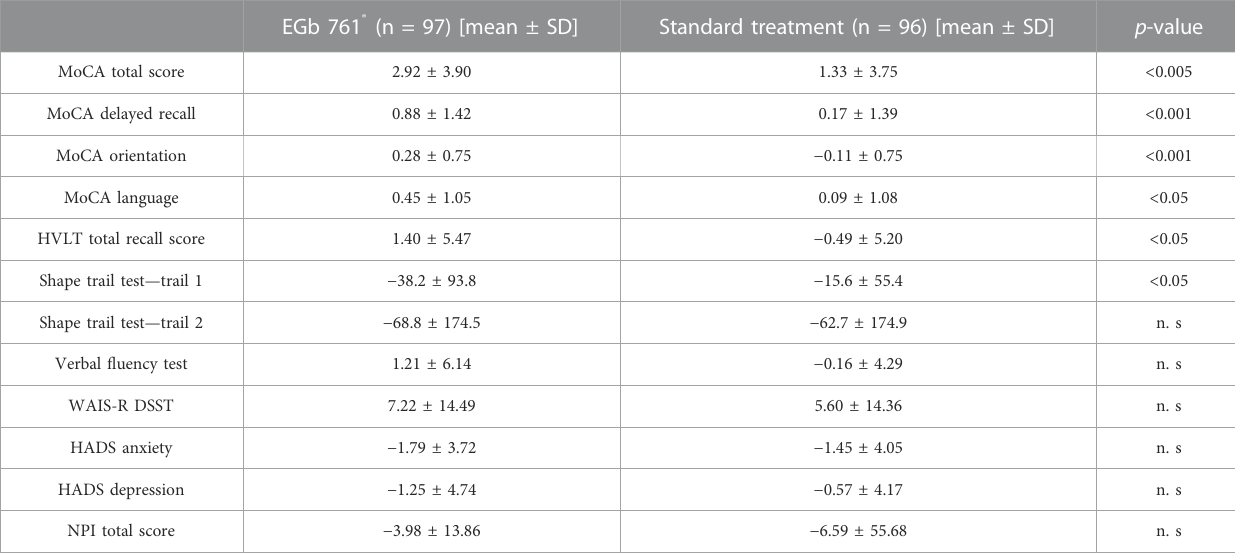
TABLE 2 Ef fi cacy outcomes. Changes from baseline to 24 week in cognitive tests and neuropsychiatric rating scales. Data are n (%) and mean